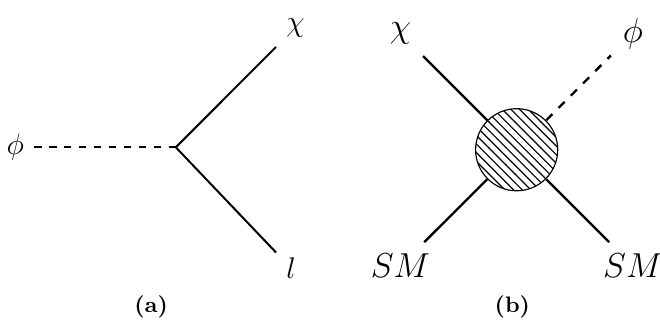
Figure 1 . The Feynman diagrams for the most important conversion